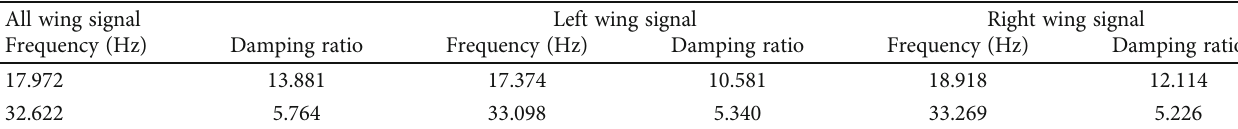
Table 4: Modal parameter estimation results of the wing symmetrical